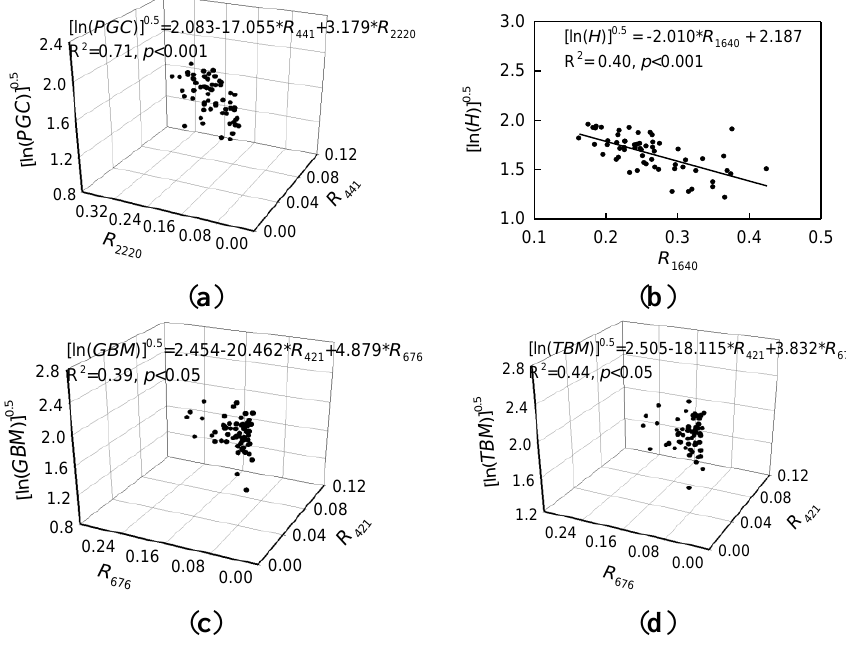
Figure 5. The empirical relationships between transformed ( a ) PGC (%); ( b ) H (cm); ( c ) GBM (g∙m −2 ); and ( d ) TBM (g∙m −2 ) and canopy reflectance in Inner Mongolia. The significant driving variables were selected with stepwise linear regression with p < 0.05.